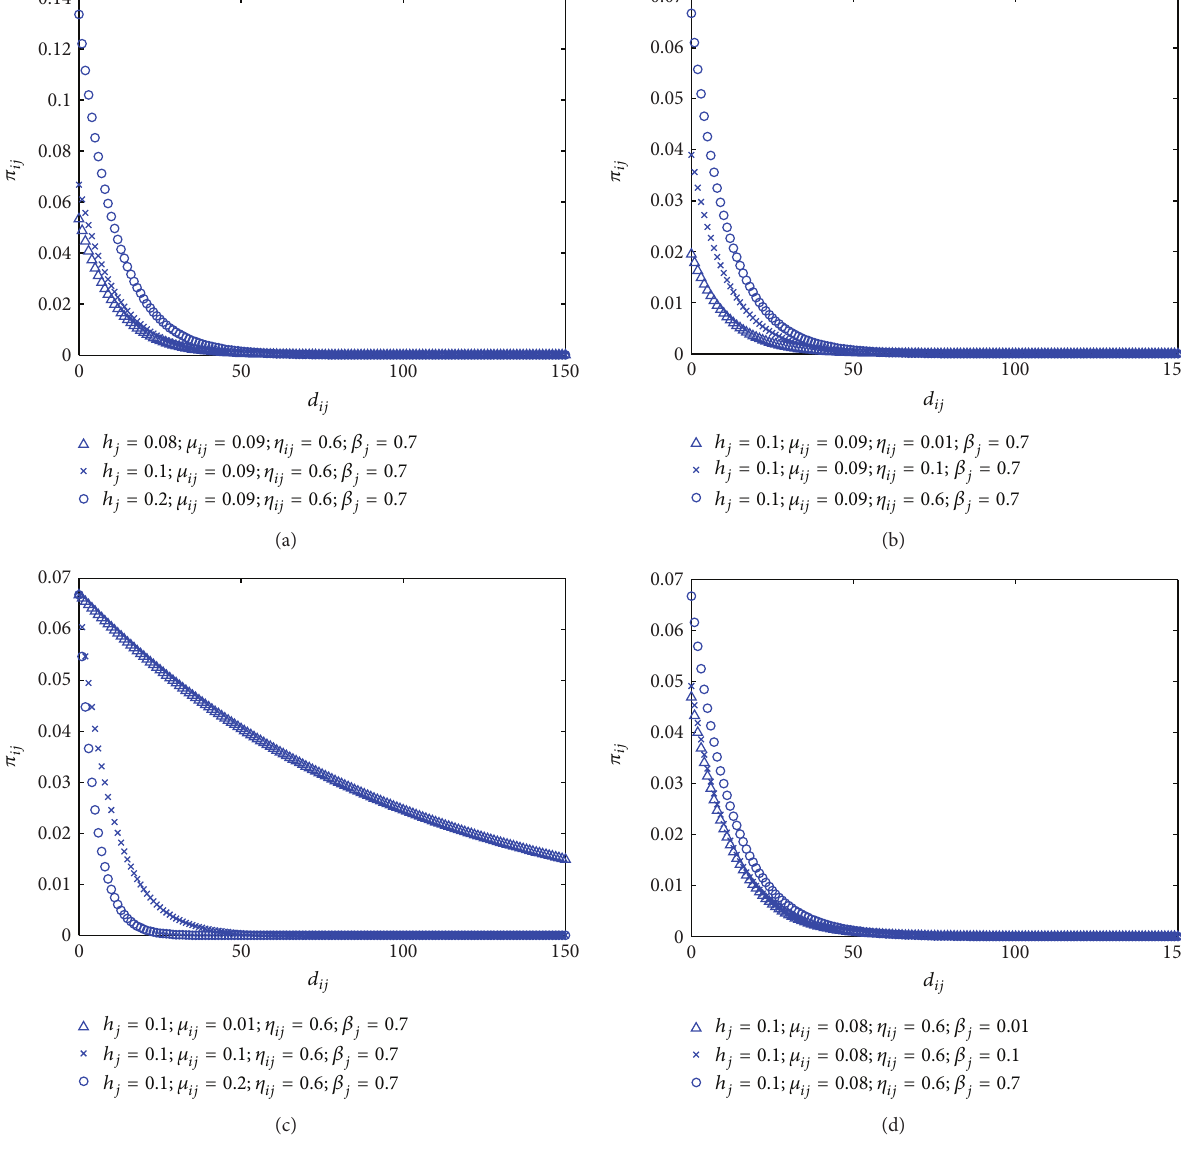
Figure 2: Effect of spatial distance on credit risk contagion in the CRT network with different values of ℎ 𝑗 , 𝜇 𝑖𝑗 , 𝜂 𝑖𝑗 , and 𝛽 𝑗 . 𝛽 𝑗 on credit risk contagion in the CRT network than Figure